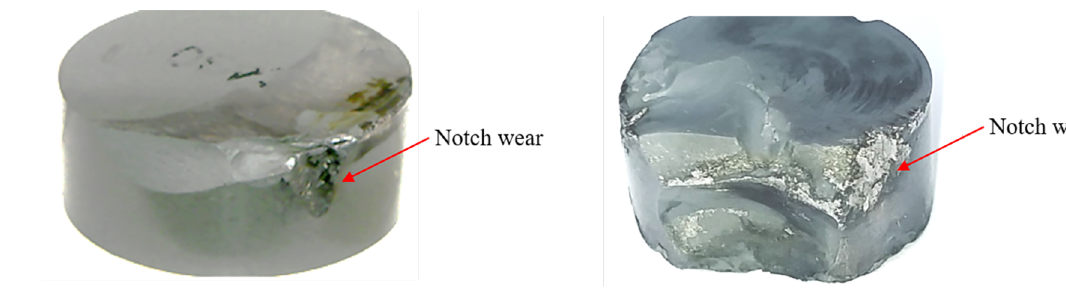
Figure 1. The experimental set-up